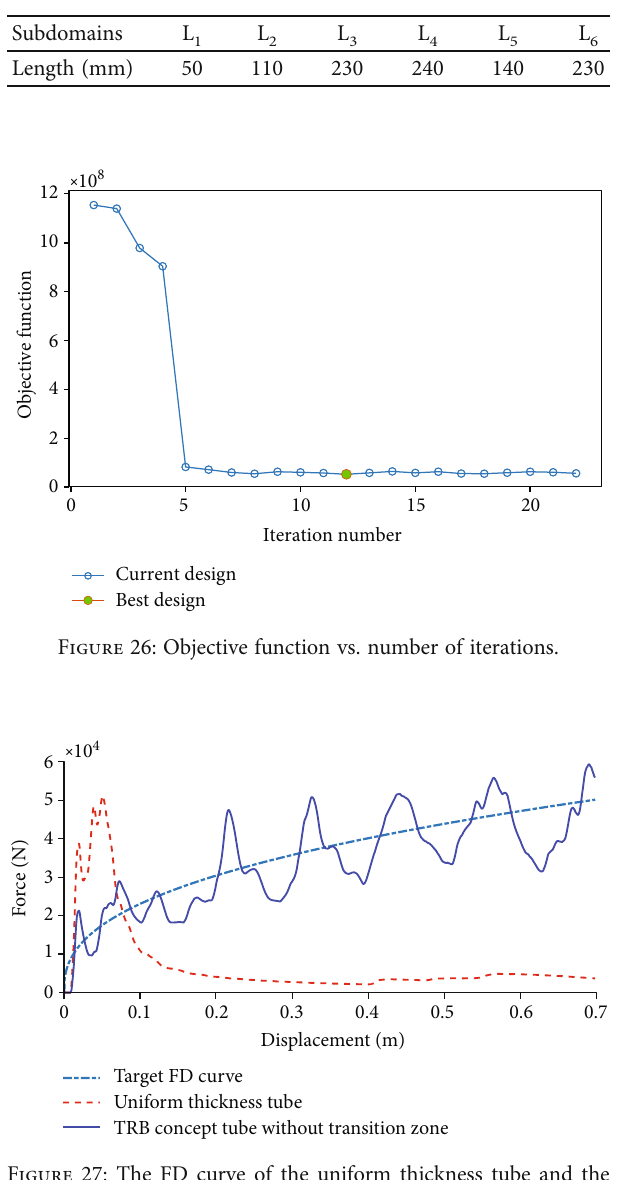
Table 6: Length of the TRB concept tube without transition zone.